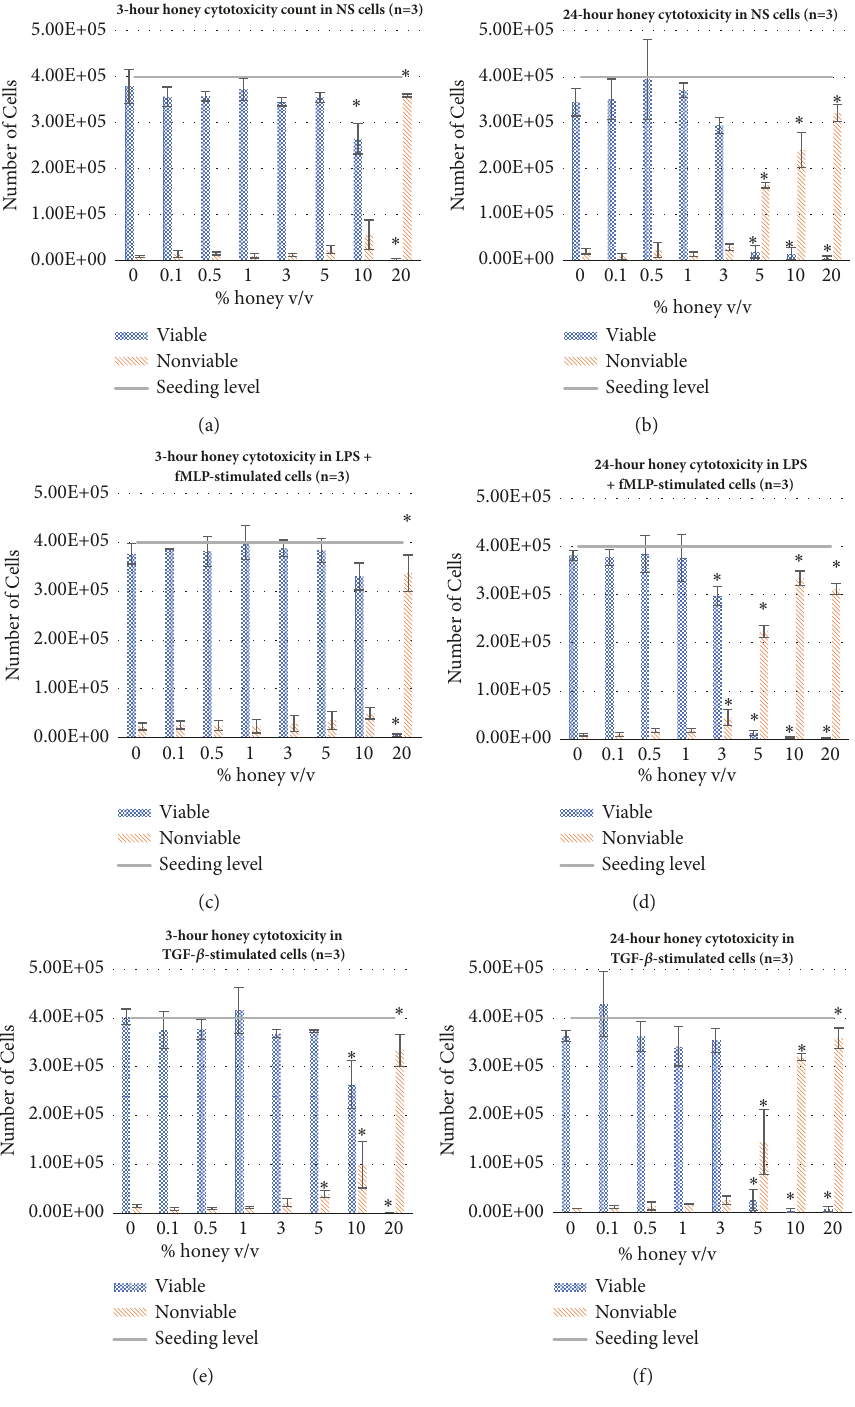
Figure 2: Viable and nonviable cell counts of NS, LPS + fMLP-stimulated, and TGF- 𝛽 -stimulated dHL-60s cultured at each honey concentration for 3 (a, c, e) and 24 (b, d, f) hours. ∗ indicates a statically significant difference from the respective 0% honey control of each cell type, viable or nonviable, at each timepoint. 𝛼 =0.05, measured via one-way ANOVA with Holm-Sidak post